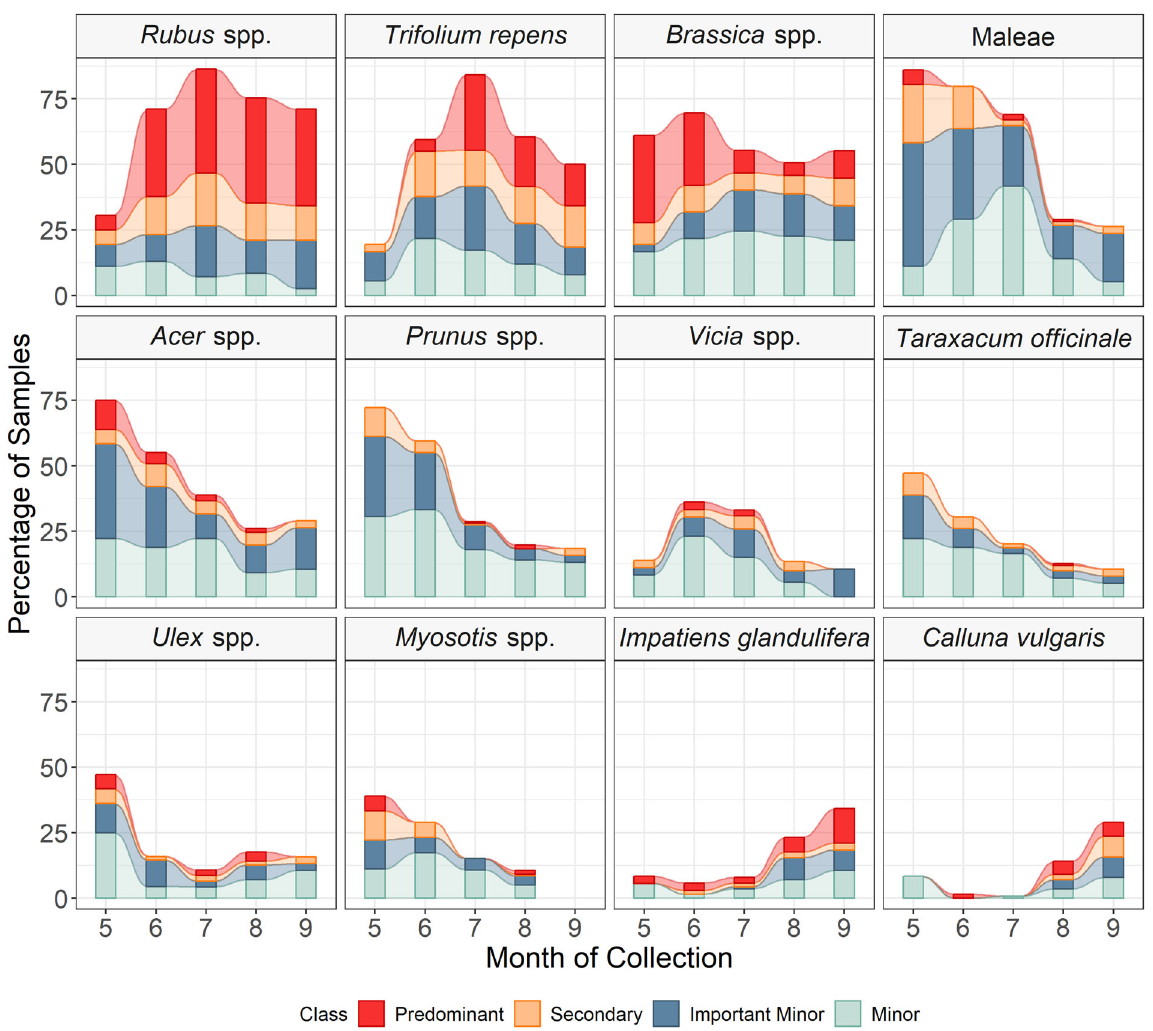
Fig. 3 The most abundantly found plant taxa in the honey samples analysed using DNA metabarcoding are summarised as a proportion of samples through the season. Plant taxa illustrated are the most frequently found plant taxa in 2017 at a predominant and secondary level. Samples collected in April ( n = 3) and October ( n = 7) were excluded. Sample sizes: May ( n = 39), June ( n = 71), July ( n = 147), August ( n = 155), September ( n = 43). Predominant: >45% of sequences returned in a sample, secondary: 15 – 45%, important minor: 1 – 15% and minor <1%. The overall height of the bar indicates the total proportion of samples with that